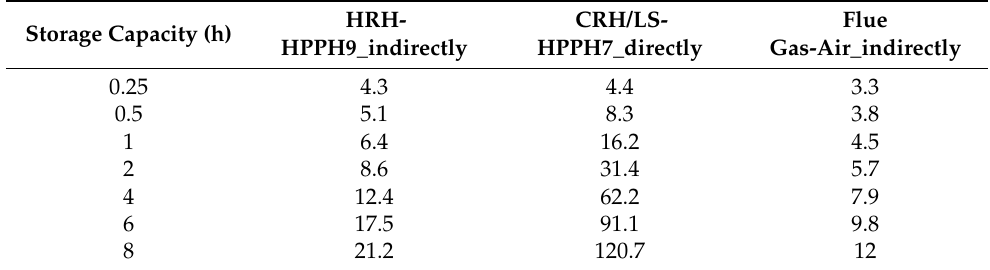
Table 9. Investment costs in relation to storage size (discharge hours at full load) in EUR million. Storage Capacity (h)